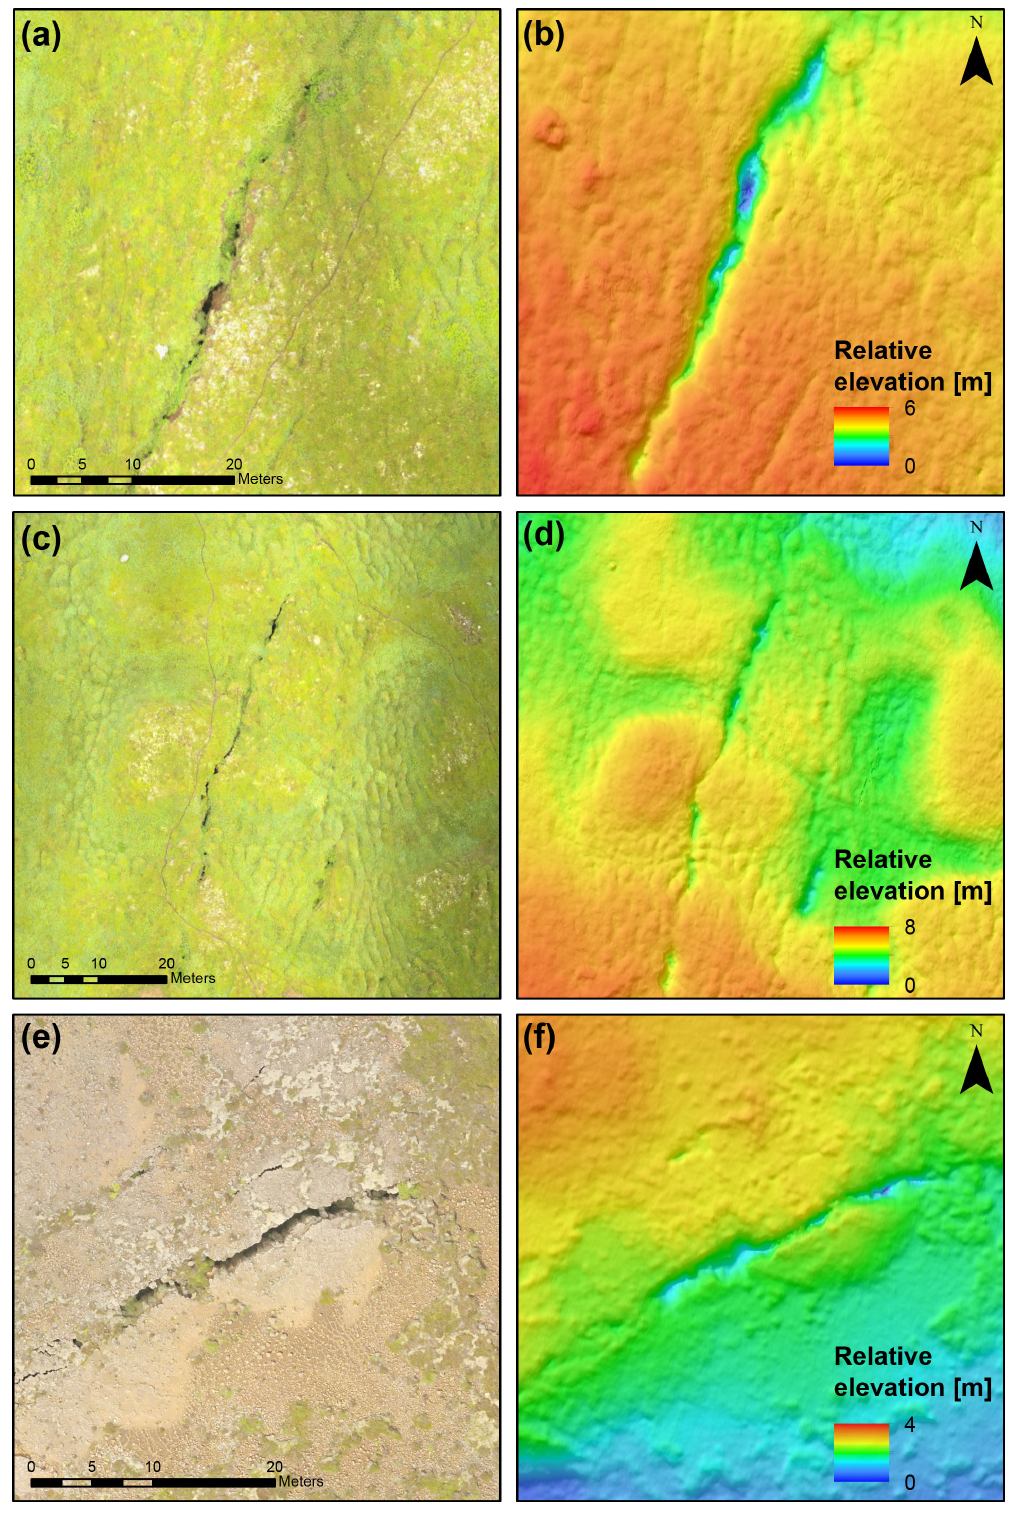
Figure 15. Samples showing the resolution of our DEMs and orthomosaics on fissures: (a, c, e) orthorectified mosaics and (b, d, f) DEMs. (a) – (d) Ásbyrgi; strong vegetation and soil cover the clear edges of the fissures. Erosion of soil into the fissure leads to a funnel-shaped opening at the surface; 66 ◦ 1 (cid:48) 8 (cid:48)(cid:48) N, 16 ◦ 35 (cid:48) 20 (cid:48)(cid:48) W, and 66 ◦ 1 (cid:48) 10 (cid:48)(cid:48) N, 16 ◦ 35 (cid:48) 19 (cid:48)(cid:48) W. (e, f) Vogar, where less soil and vegetation allow a more accurate mapping of the opening; 63 ◦ 57 (cid:48) 55 (cid:48)(cid:48) N, 22 ◦ 21 (cid:48) 59 (cid:48)(cid:48) W. Projection: WGS1984 UTM 27N and